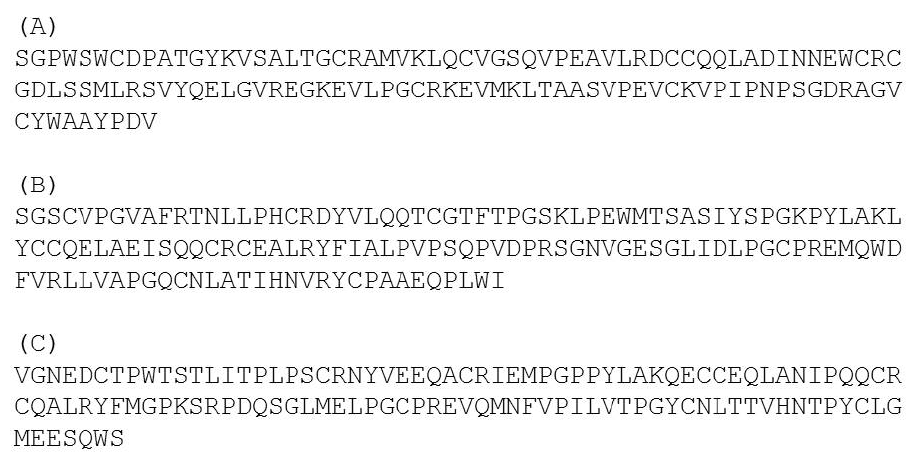
Figure 3. Identification of the three ATI polypeptides by LC-MS/MS. ( A ) 0.28; ( B ) CM3 and ( C ) CM16. Matching peptide sequences are underlined.